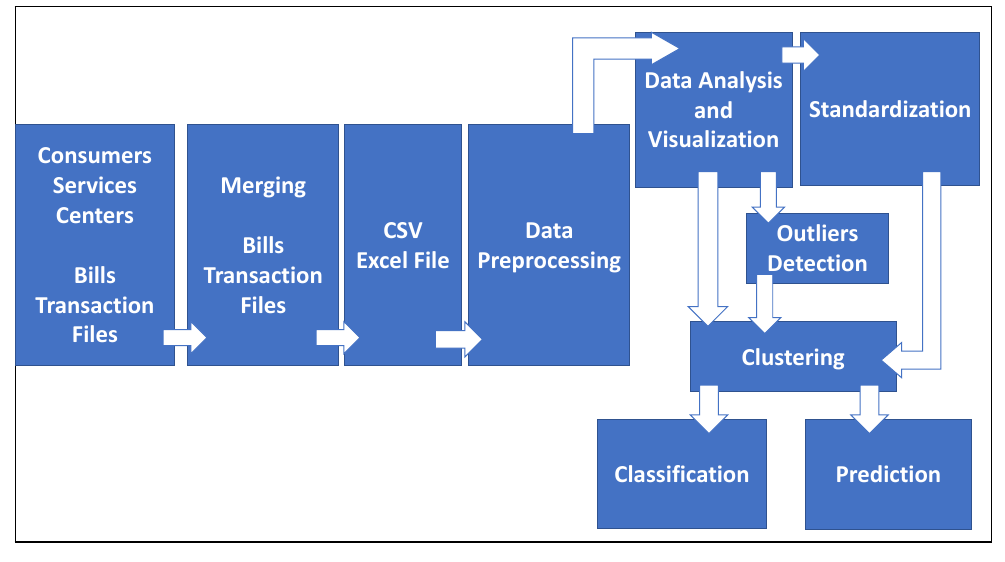
Figure 2. Data mining work flow applied in the